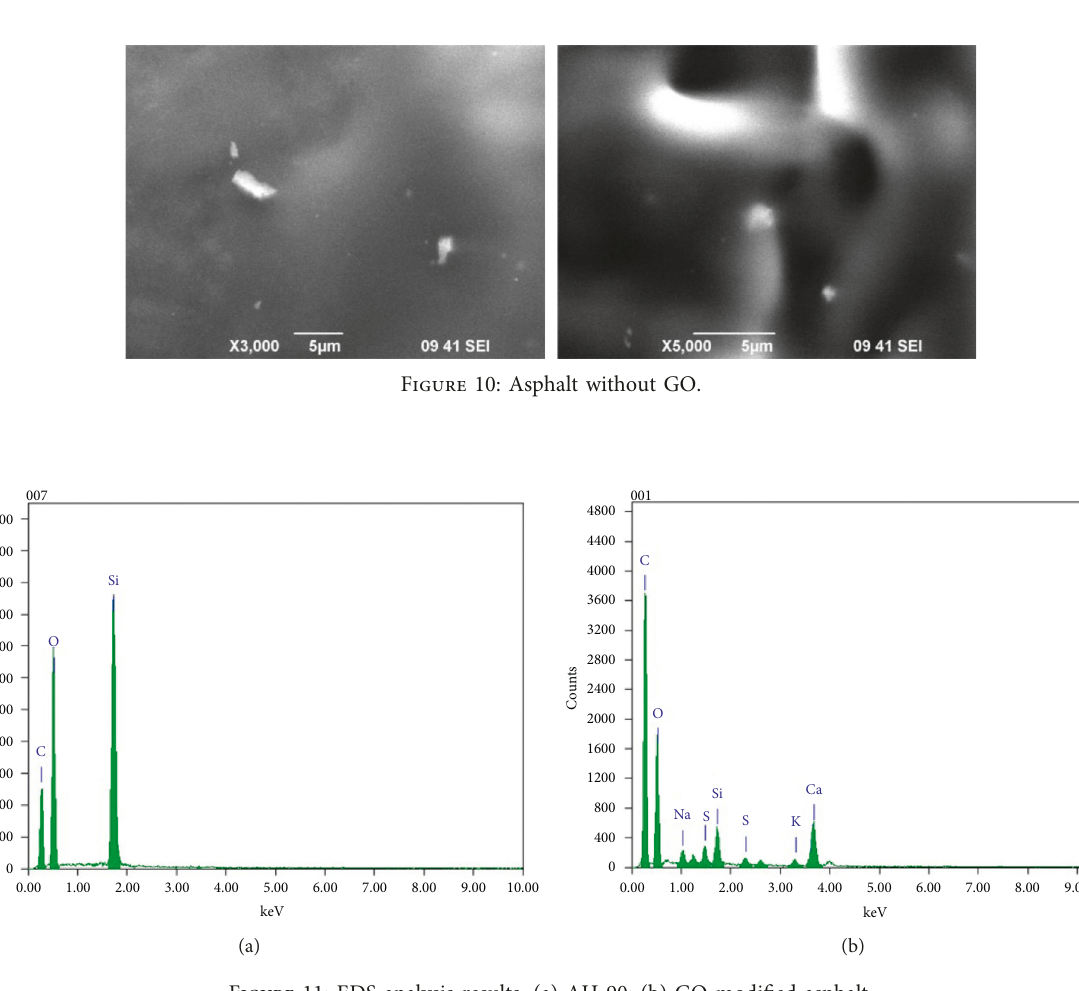
Figure 9: SEM images of GO-modified asphalt. (a) Typical microstructure 1. (b) Typical microstructure